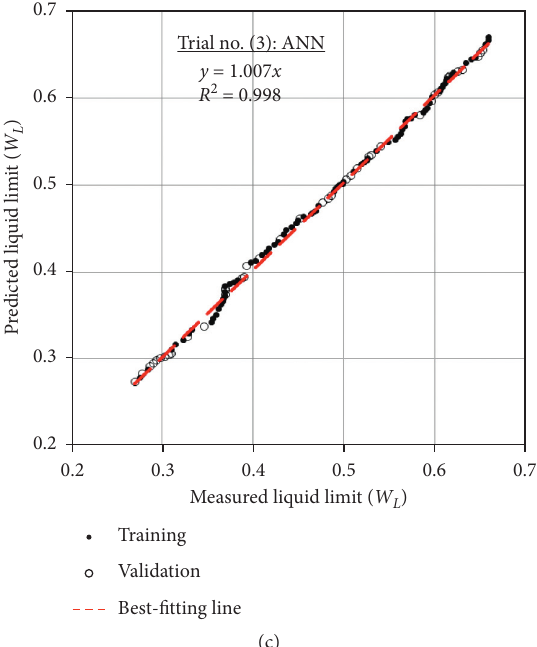
Figure 7: Relation between the predicted and calculated ( W